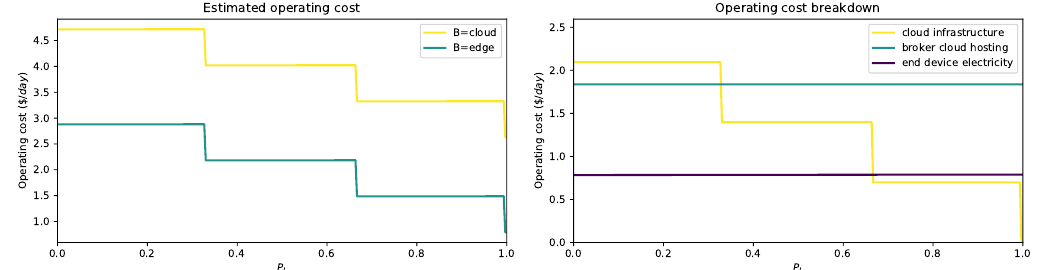
Figure 12. Operating cost estimation for different deployment schemes. x -axes of both charts show the fraction of devices being hosted on the local thermostat, as opposed as on the cloud: every point is a deployment scheme that has been exercised retaining functionality, right-hand points are deployments with progressively more component moved to the edge of the network. Pulverization allows for exercising different deployment schemes without any change to the functional specification. Different lines on the eft-hand chart show projected pricing for hosting the broker on the self-hosted edge servers or moving it on the cloud. The right-hand side chart shows a breakdown of the overall pricing into its constituent components. The forecasted usage for the broker does not overcome the first pricing level; it is thus a constant contribution. Idle time power drain dominates the electricity consumption of smart thermostats (although the line looks flat, it imperceptibly grows): this suggests that moving computation towards the edge is generally cheaper, and suggests that better power saving strategies than keeping the device idle should be devised. Cloud hosting pricing decreases when devices are moved to the edge; since we request a new cloud instance every 100 thermostats hosted on cloud and pricing goes per-instance, the chart is